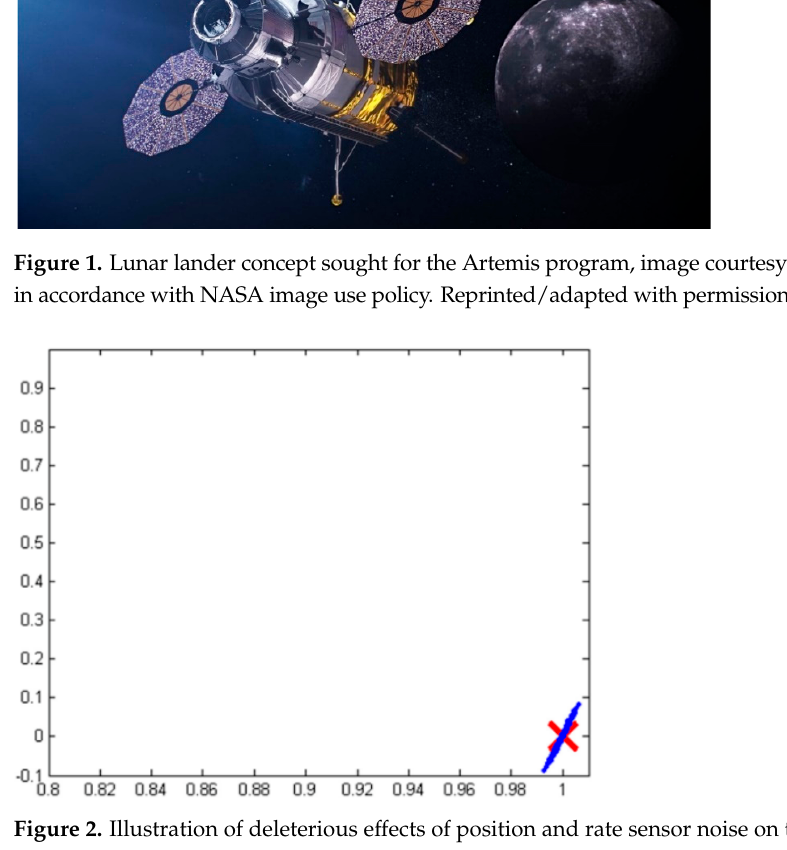
Figure 1. Lunar lander concept sought for the Artemis program, image courtesy NASA [2], image use in accordance with NASA image use policy. Reprinted/adapted with permission from Ref. [3]. NASA”.